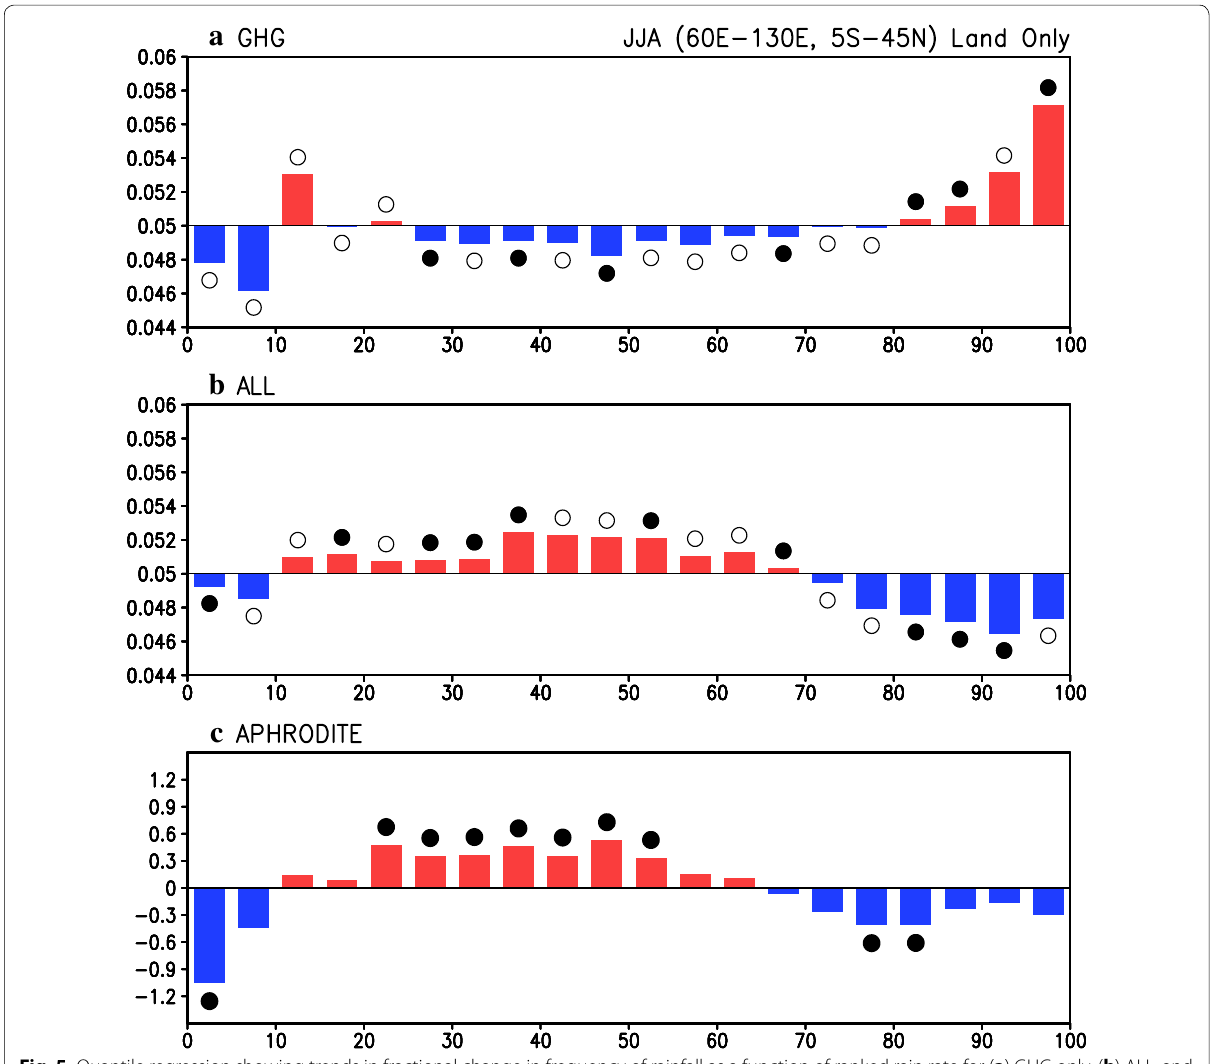
Fig. 5 Quantile regression showing trends in fractional change in frequency of rainfall as a function of ranked rain rate for ( a ) GHG only, ( b ) ALL, and ( c ) APHRODITE rainfall observation, for the period 1950–2005. In a and b , open (solid) circle annotating each quantile represents 10 (12) out of 19 models having the same sign. In c solid circle represents 95% statistical